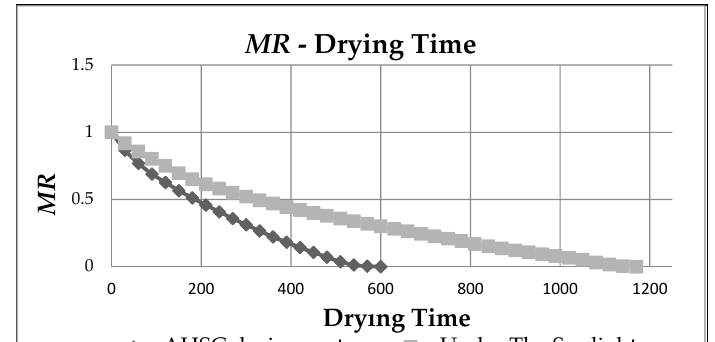
Figure 6. MR changing with drying time. Appl. Sci. 2018 , 8 , x FOR PEER REVIEW